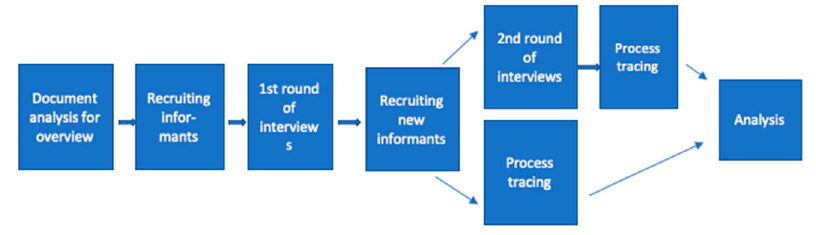
Figure 2. Methodology, stepwise.